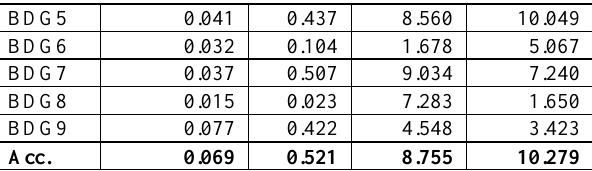
Table 4. GNSS measurements accuracy